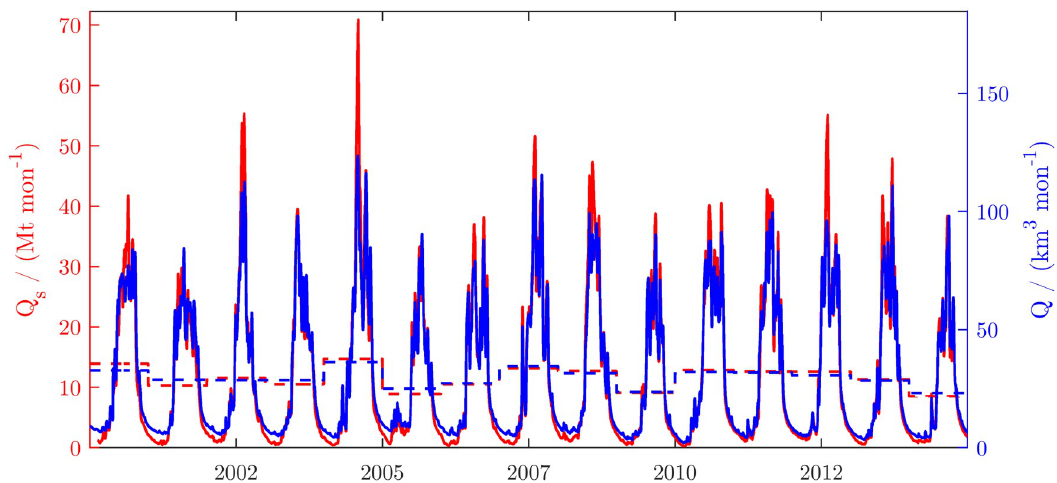
Fig 7. Daily discharge and wash load transport of the Ayeyarwady at Pyay. Dashed lines indicate the annual averages. The load was estimated by multiplying the gauged discharge with the weekly estimate of SSSC interpolated to